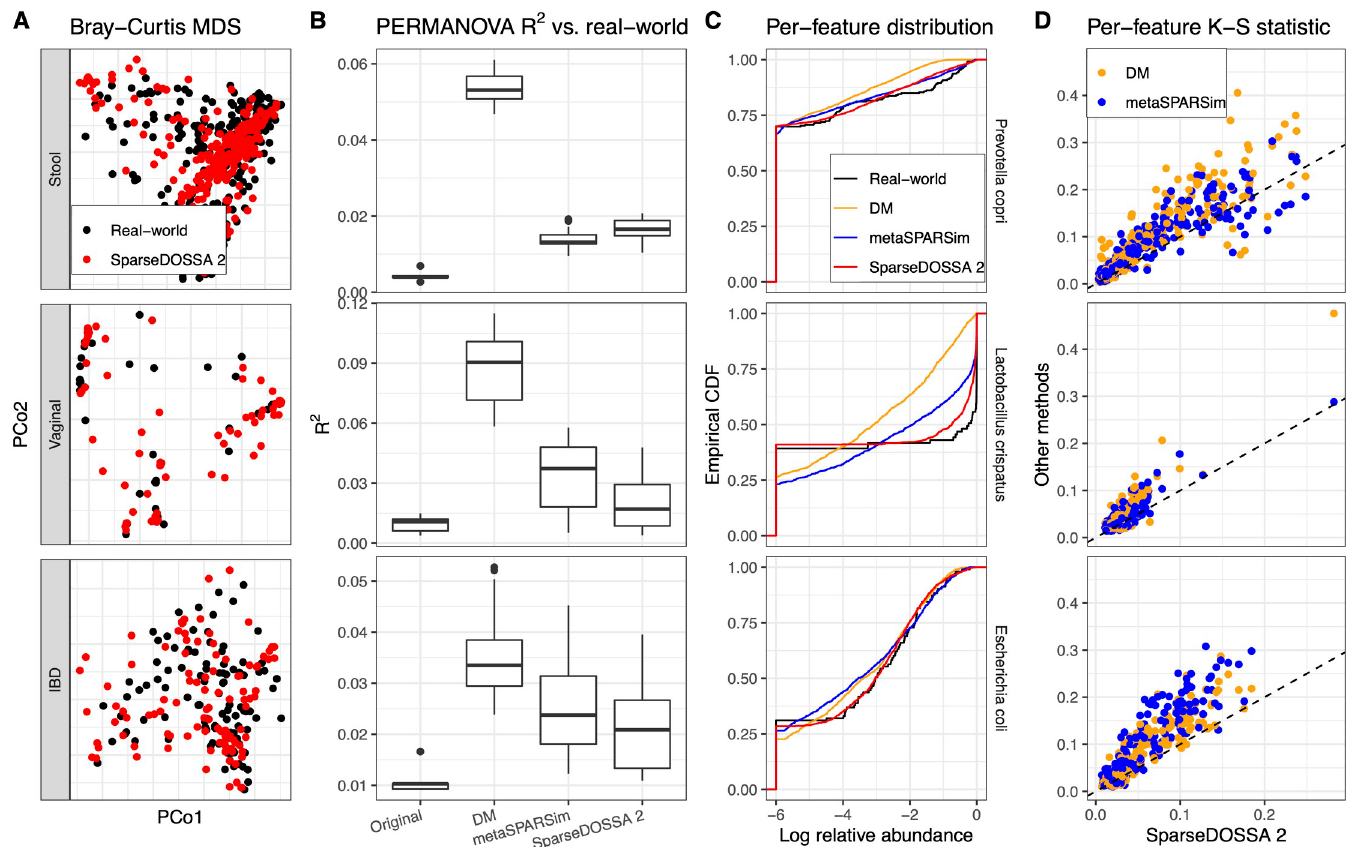
Fig 2. SparseDOSSA accurately recapitulates different microbial community structures. We compared SparseDOSSA 2 simulated microbial counts versus those of three human microbiome training template datasets (Stool, Vaginal, and IBD). A) Bray-Curtis ordination shows global agreement between SparseDOSSA simulated microbial abundance profiles and those of their originating real-world populations. B) This was quantified by PERMANOVA R 2 statistics, showing that SparseDOSSA simulated samples were significantly less systematically differentiated from their targets than existing DM and metaSPARSim methods in almost all cases (Wilcoxon rank sum test p-values included in S3 Table ). R 2 compared against randomly split original real-world data are included as baseline controls. C) Representative features from each environment are similarly distributed between real-world and SparseDOSSA simulated samples, as shown in empirical cumulative distribution functions (CDFs) of log-10 relative abundances (with pseudo value 1e-6 to visually represent zeros). D) Per-feature Kolmogorov-Smirnov summary statistics quantify that SparseDOSSA outperforms existing methods in simulating realistic feature-level relative abundance distributions. First, the similarity between the model-simulated feature abundance distribution versus that in the real-world dataset is quantified with K-S statistics. Then, the K-S statistics for SparseDOSSA and the other two models (DM and metaSPARSim) are plotted on the x- and y-axis, respectively (each point representing one feature, smaller K-S statistics represent better approximation). Lastly, the K-S statistics of SparseDOSSA versus other models are formally tested using Wilcoxon signed rank tests (p-values are significant and included in S4 Table ).